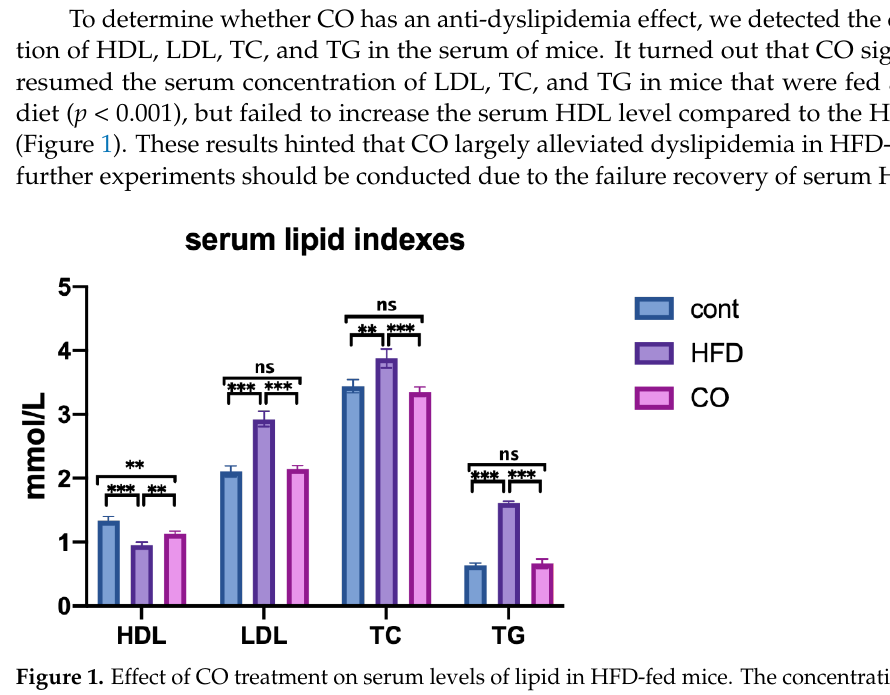
Figure 1. Effect of CO treatment on serum levels of lipid in HFD-fed mice. The concentration of High-density lipoprotein (HDL) , Low-density lipoprotein (LDL), Total Cholesterol (TC), and Tri- glycerides (TG) in mice. Data are expressed as the mean ± SEM ( n = 10), ** p < 0.01, *** p < 0.001, ns p >